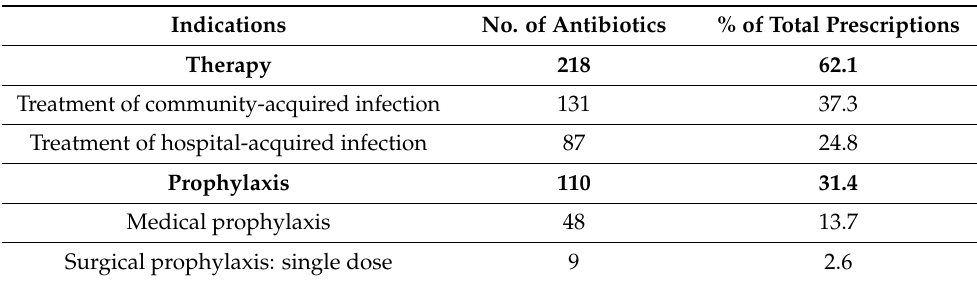
Table 5. Antimicrobials prescribed according to the indications for